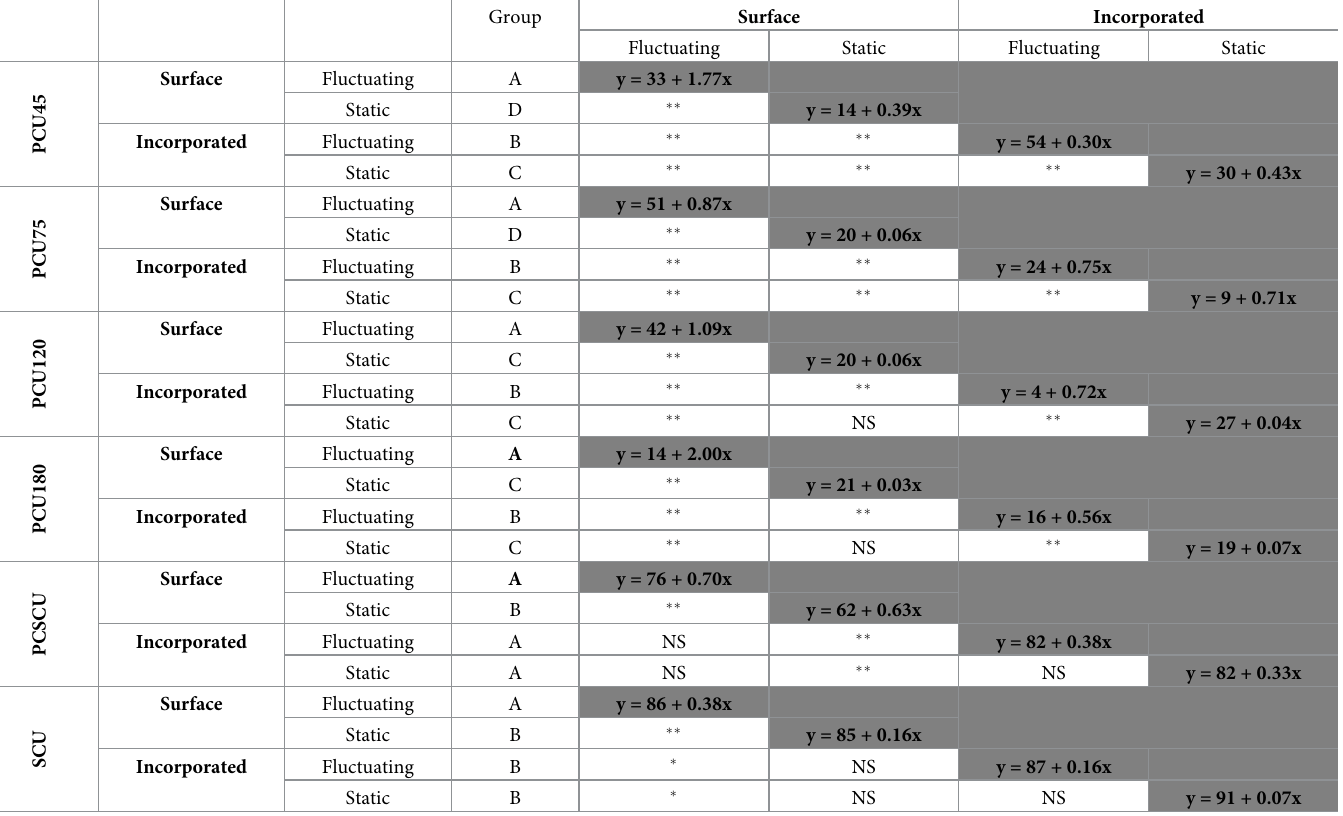
Table 1. Experiment 1 comparison of slopes of linear regression models used to model N release as a function of time for each fertilizer type and treatment combi- nation for a study with various fertilizer